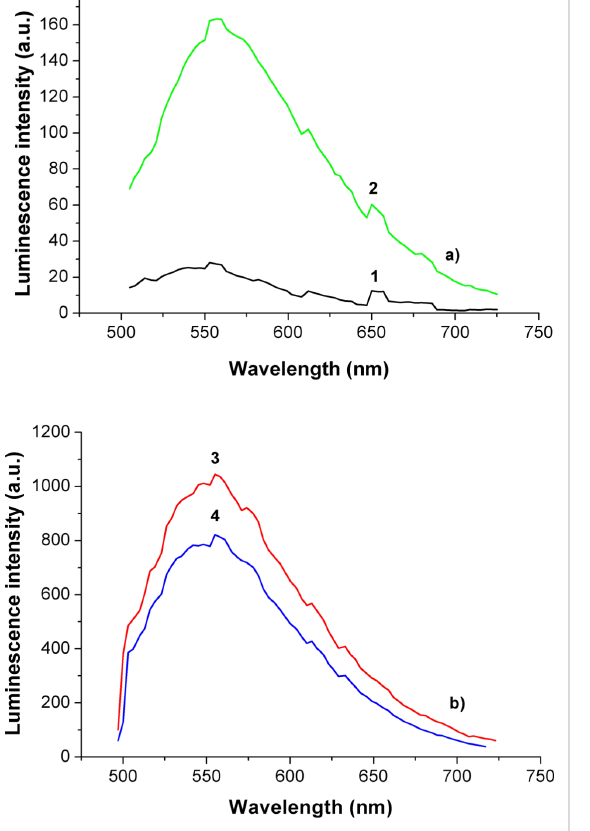
mixture of non-uniform particles, associated with silica, which in turn should be introduced to the synthesis. Otherwise the reaction yield of the synthesis without SiO 2 NPs is smaller by an order of magnitude. The excitation, luminescence and upcon- version effects in the near-IR spectral region, usually